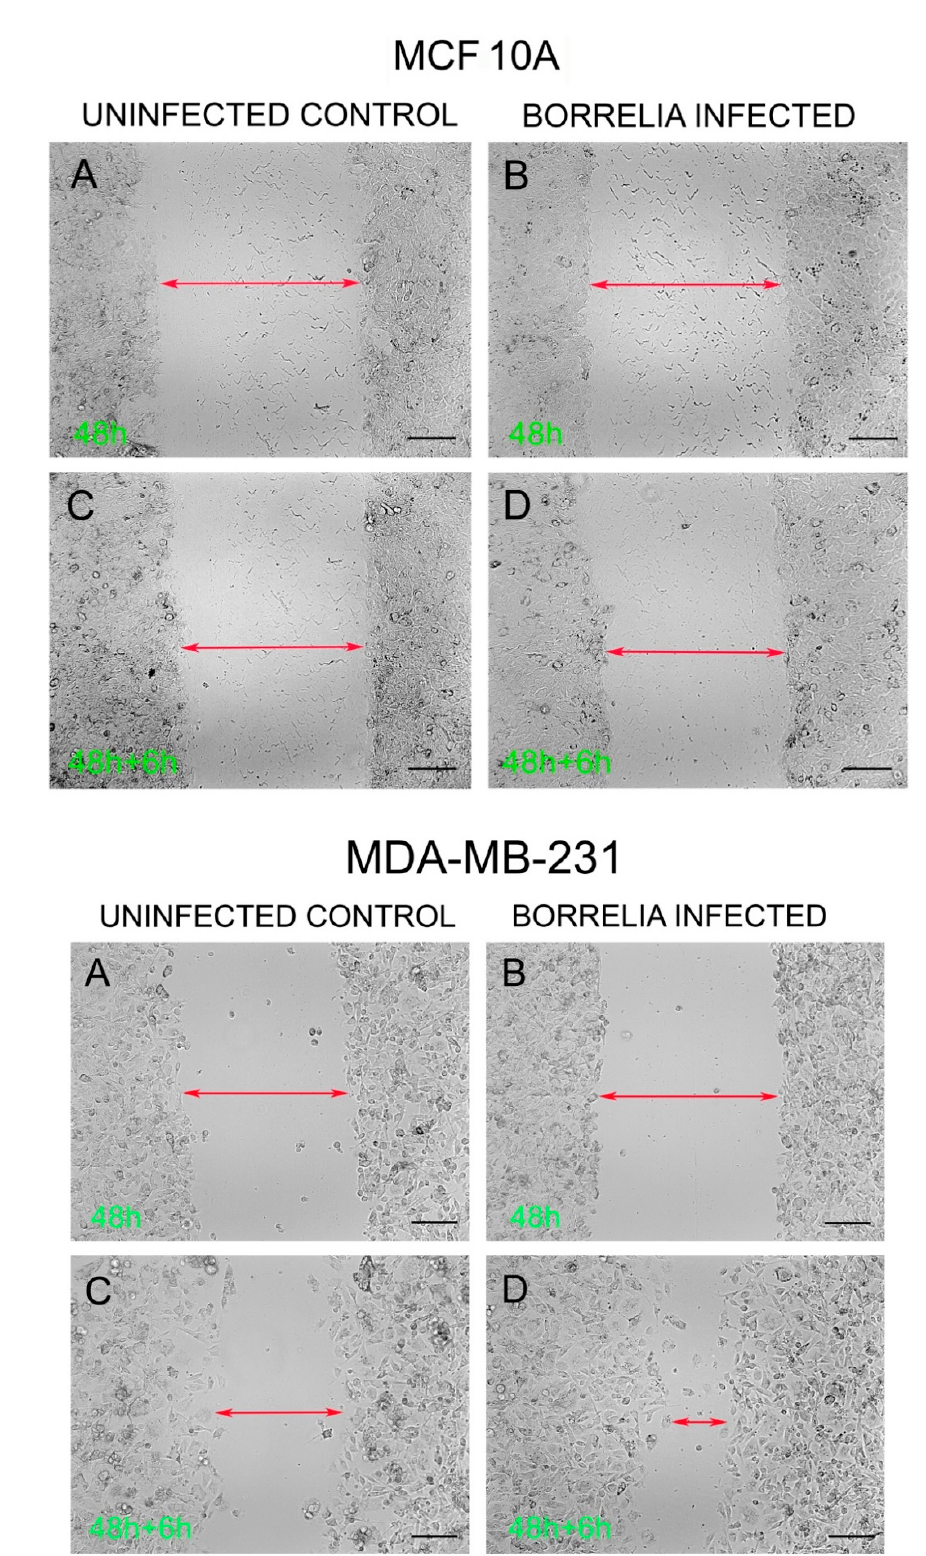
Figure 6. Wound Healing Assay of B. burgdorferi infected cells. I. MCF 10A and II. MDA-MB-231 cells after 48 h of infection and 6 h recovery. (Panels A and C ) uninfected versus (Panels B and D ) B. burgdorferi infected cells. The cells were infected for 48 h with B. burgdorferi and then a wound was induced; cell migration was assessed after an additional 6 h as described in Material and